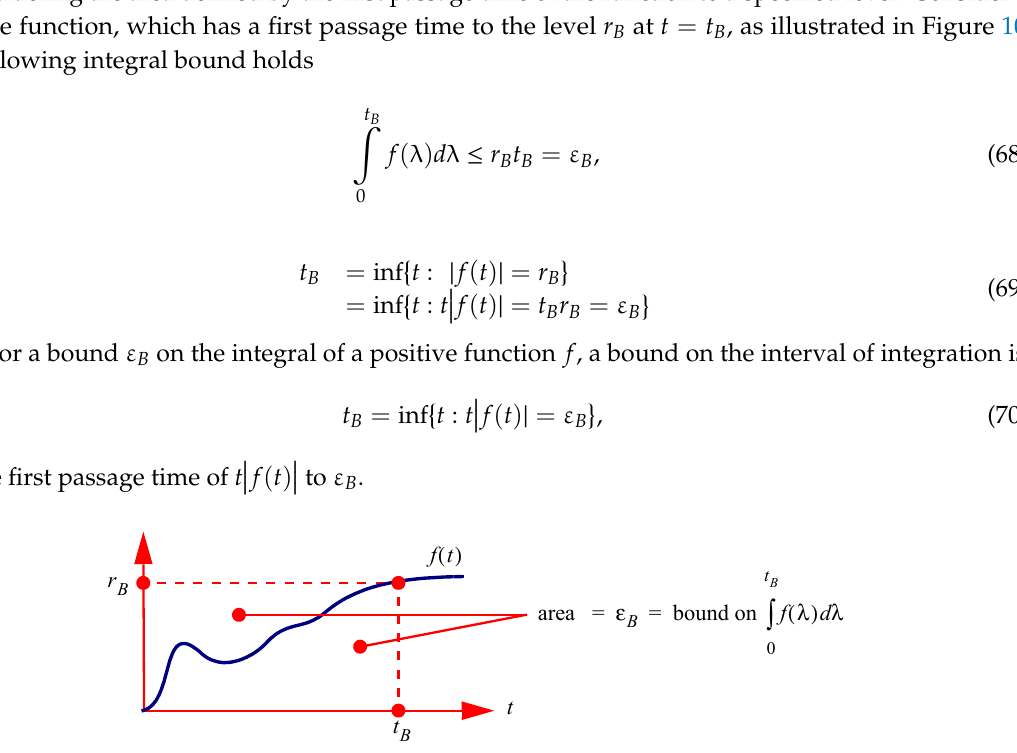
Figure 10. The area bound defined by the first passage time of a positive function to a set level.